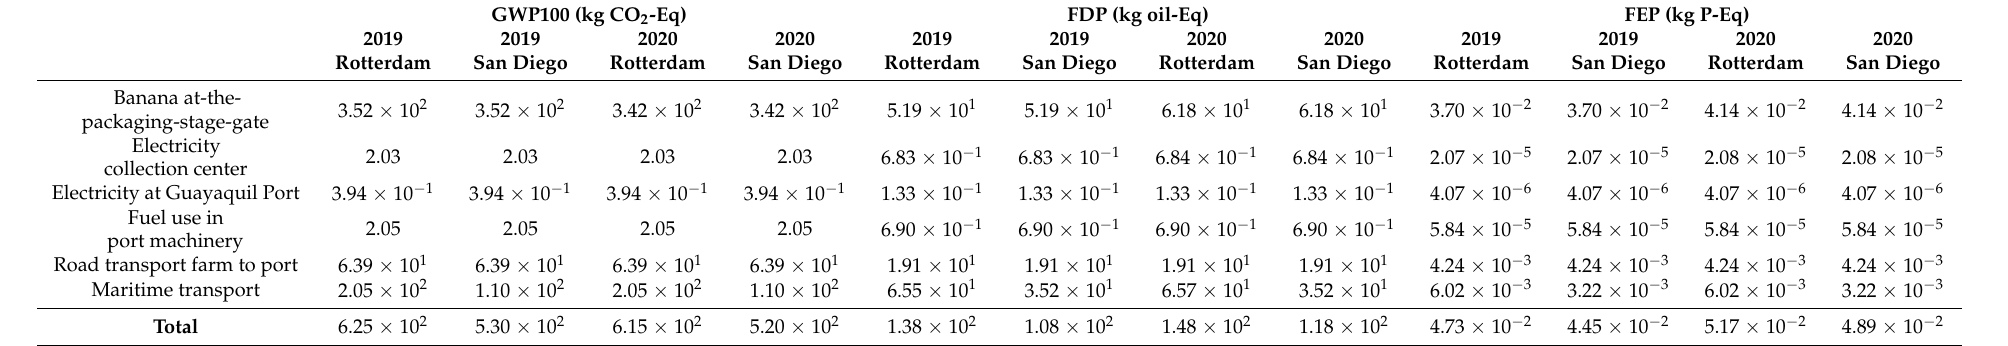
Table 6. Impact category indicator results for 1 ton of “Banana at-the-foreign-port” for years 2019 and 2020 for impact categories QWP100, FDP, and FEP.